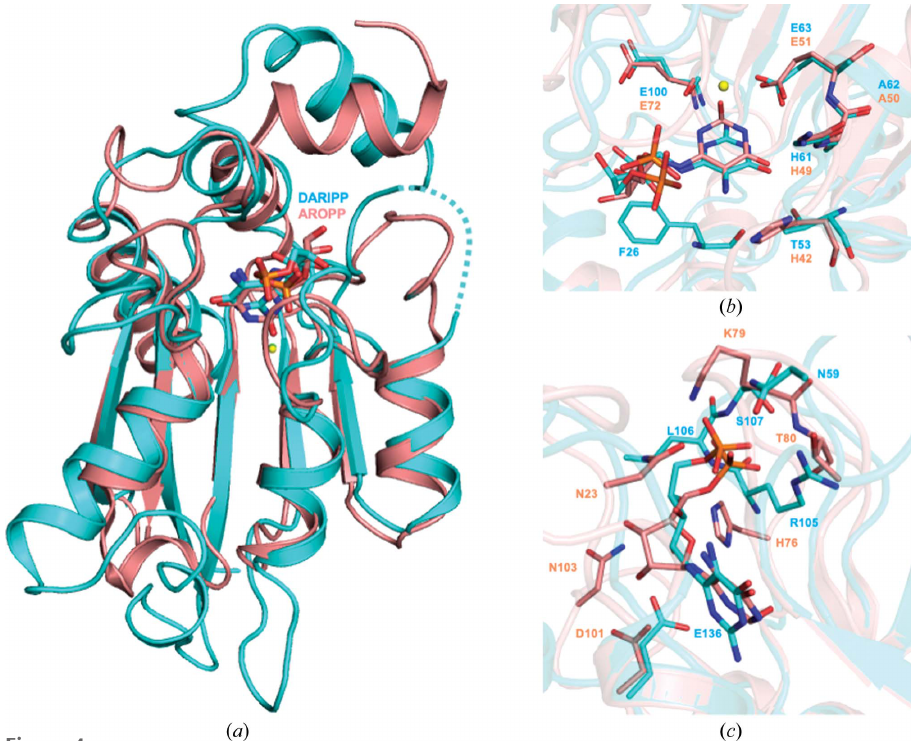
Figure 4 Structural comparison of AoRib2–DARIPP and BsRibG–AROPP. ( a ) Overall structure comparison of the deaminase domains of AoRib2 (cyan) and BsRibG (salmon). ( b ) Superposition of the structures of AoRib2–DARIPP and BsRibG–AROPP showing the evolutionary conservation of nucleobase-recognition residues. ( c ) Superposition of the structures of AoRib2–DARIPP and BsRibG–AROPP showing the structural divergence of phosphate- and ribose-recognition